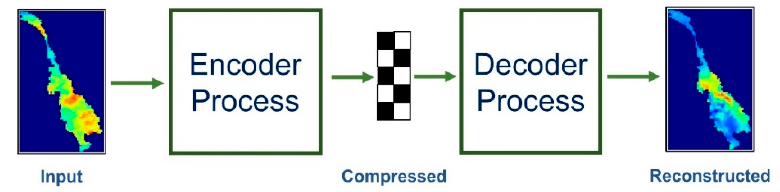
Figure 1. Illustrated diagram of CAE network